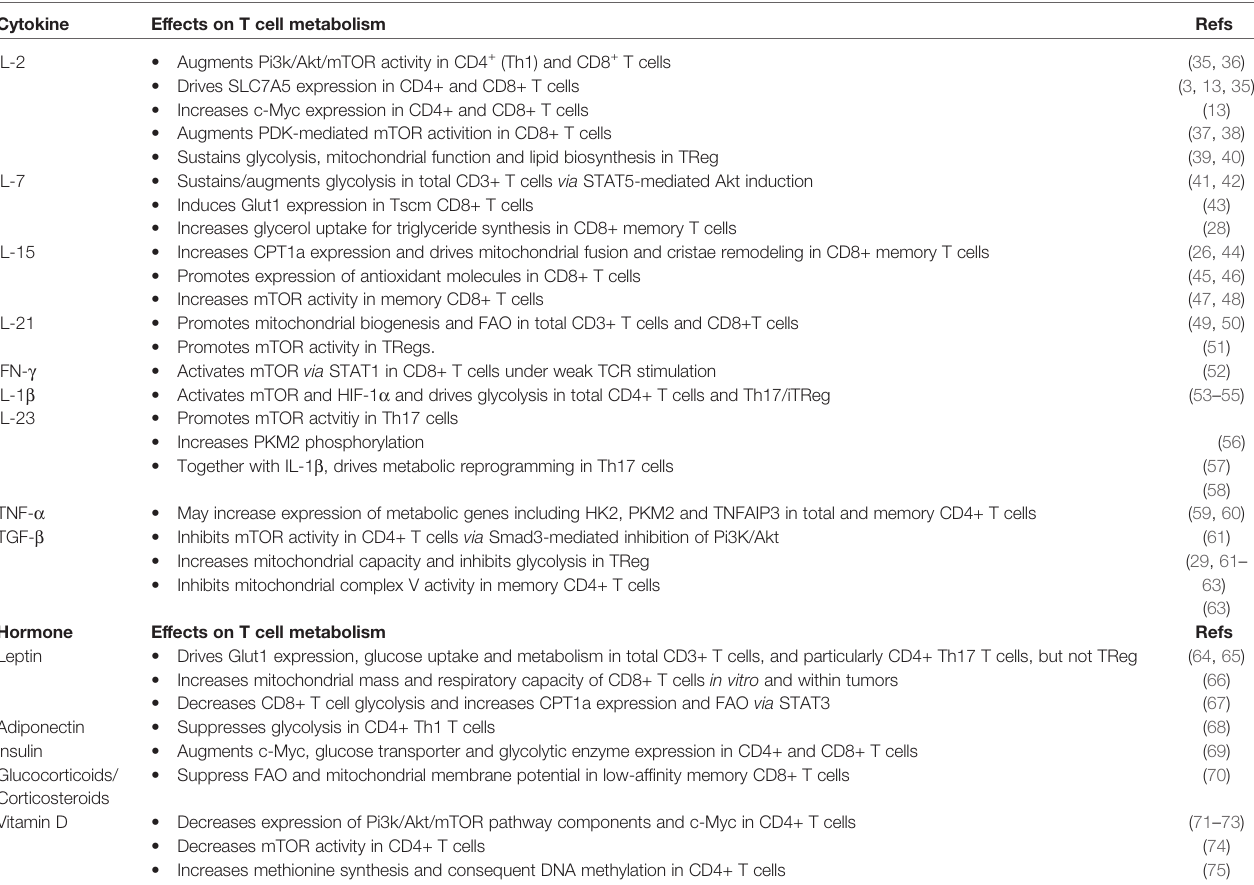
TABLE 1 | Effects of cytokines + hormones on T cell metabolism. Cytokine Effects on T cell